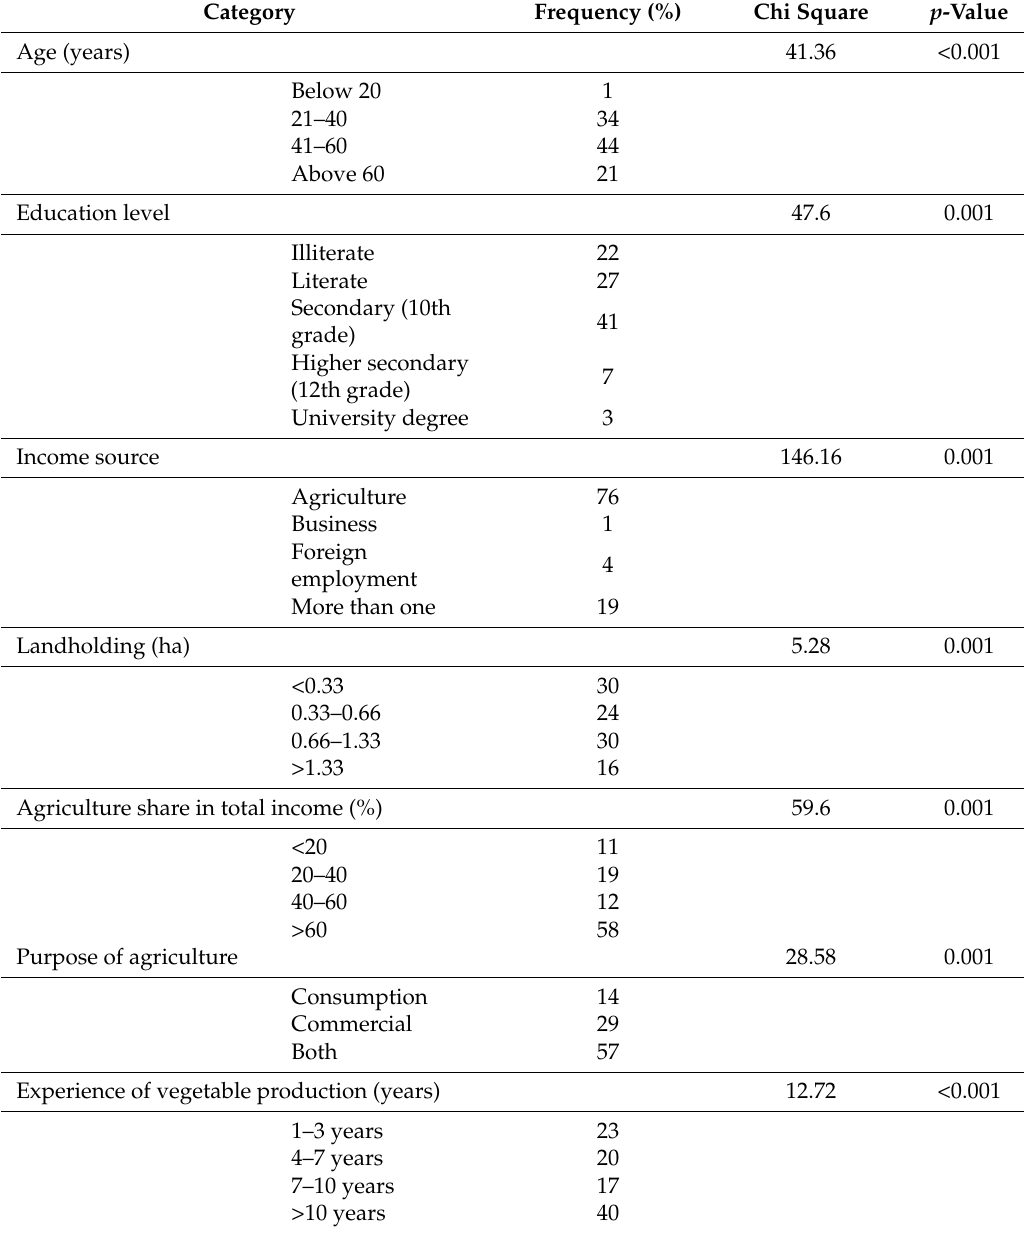
Table 1. Socio-demographic status of surveyed vegetable growers in Chitwan,